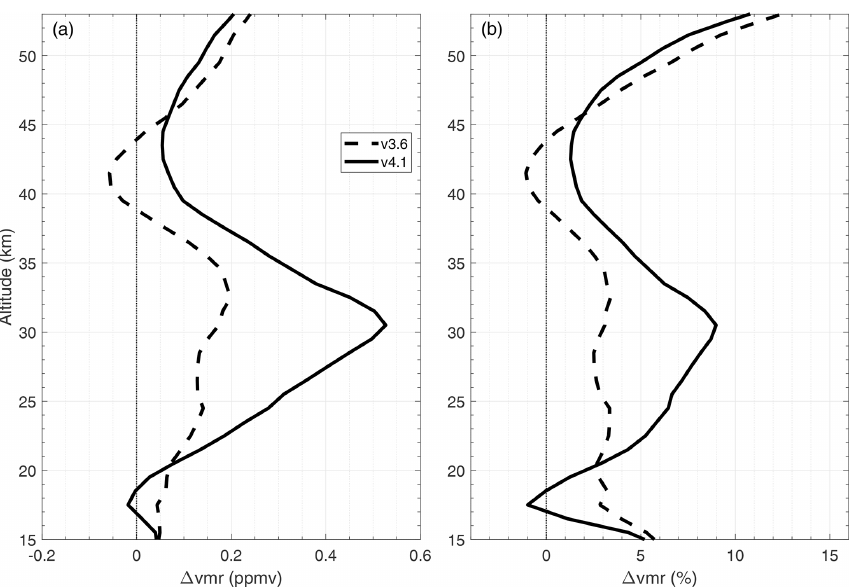
Figure 2. Weighted averages of the mean differences (a) and mean percent differences (b) for comparisons between ACE-FTS and all instruments. Dashed lines represent ACE-FTS v3.6 and solid lines represent